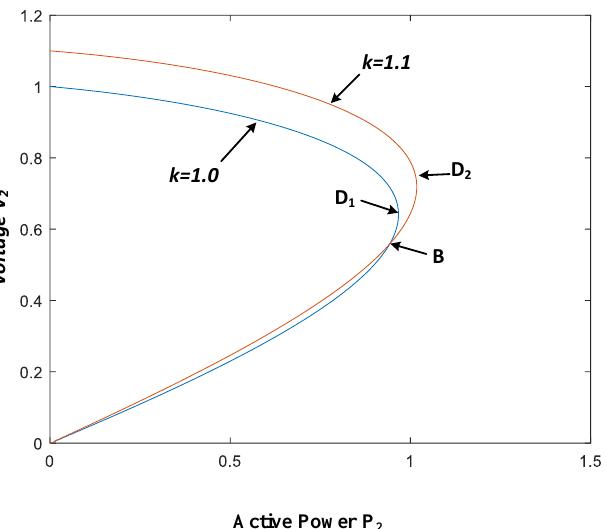
Figure 6. Positive voltage regulating effect of OLTC transformer. Point B is the intersection of the two P-V curves.